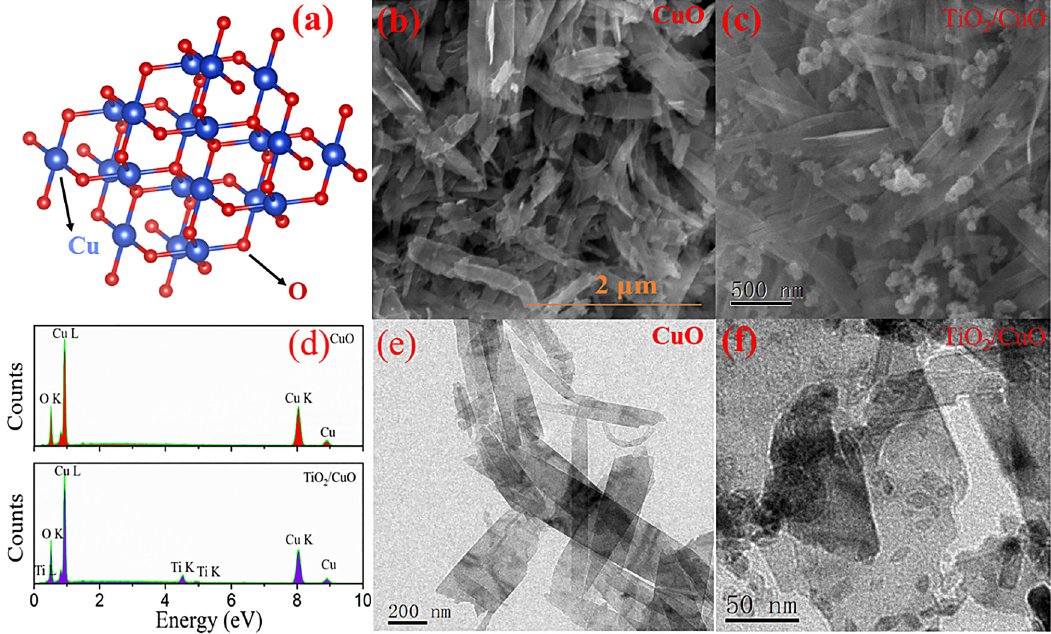
Figure 1: Microstructure and morphology characterization of cupric oxide (CuO) and TiO 2 /CuO nanocomposites. (a) Crystal structure of monoclinic CuO. (b) Scanning electron microscope (SEM) image of CuO. (c) SEM of TiO 2 /CuO. (d) Energy dispersive spectra (EDS) images of CuO and TiO 2 /CuO nanocomposites. (e) Transmission electron microscopy (TEM) of CuO. (f) TEM of TiO 2 /CuO